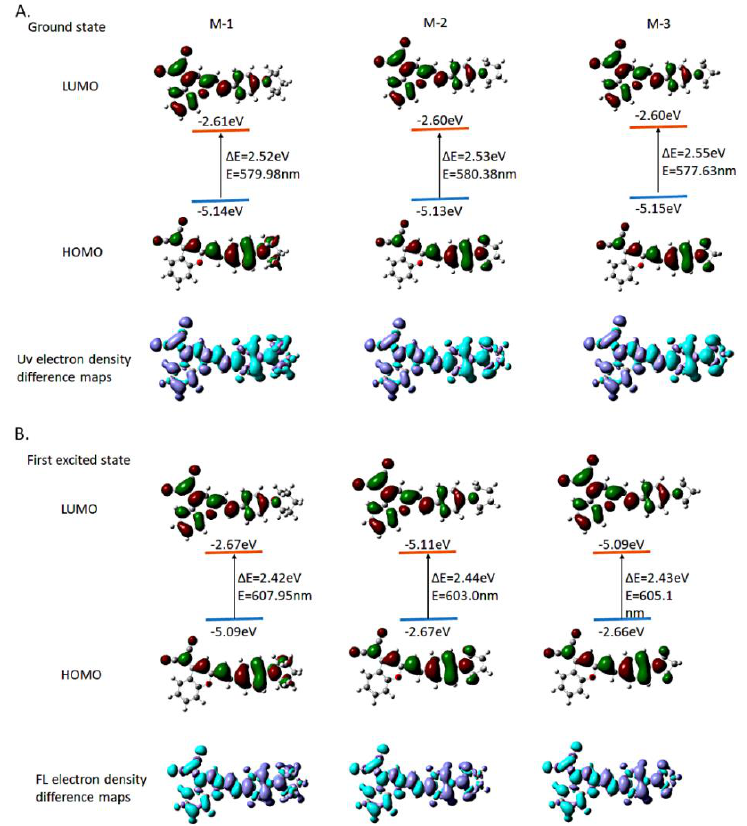
Figure 2. Frontier orbital distributions, energy levels calculated by Gaussian 16 in the ground state and first excited state. ( A ) Ground state; ( B ) First excited state.